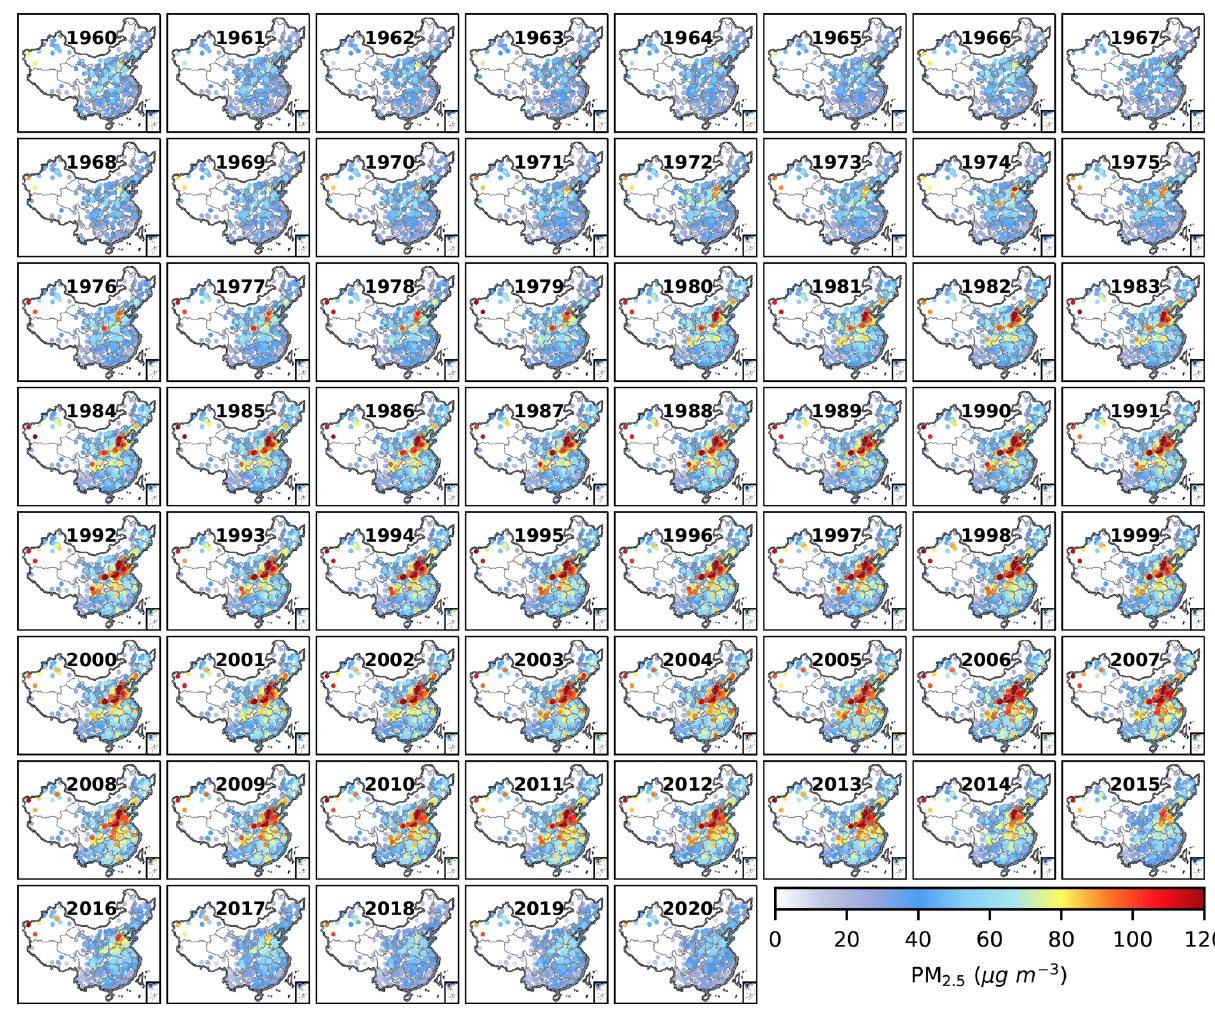
Figure 5. Spatial distribution of annual average PM 2 . 5 mass concentration at 1485 stations from 1960 to